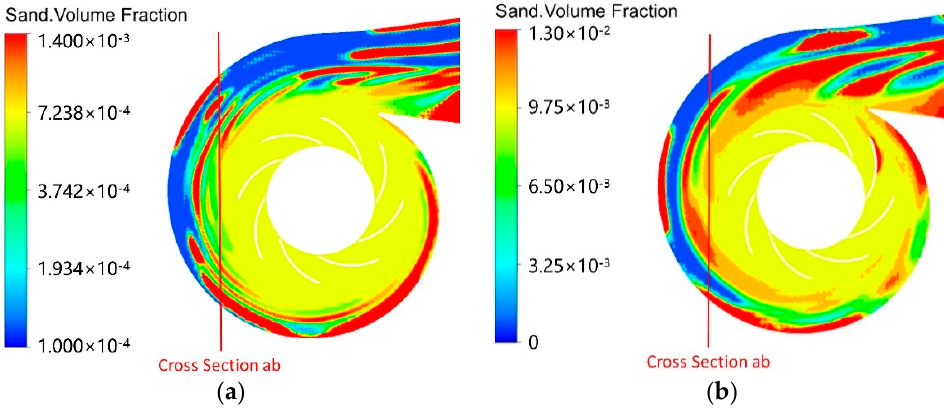
Figure 5. Cloud diagram of the variation of solid particle volume fraction in centrifugal pump with different sediment concentrations: ( a ) sediment concentration ρ sc = 0.1%; ( b ) sediment concentration ρ sc = 1%.